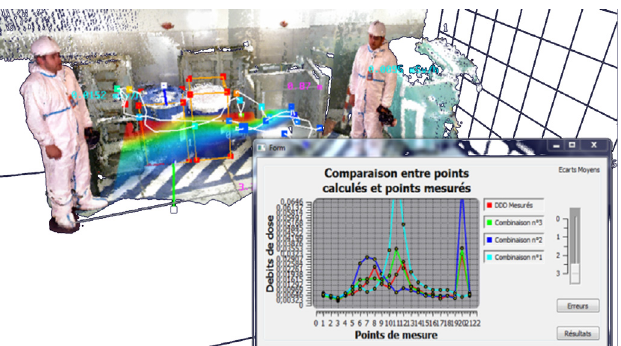
Fig. 12. Radioactive sources activities